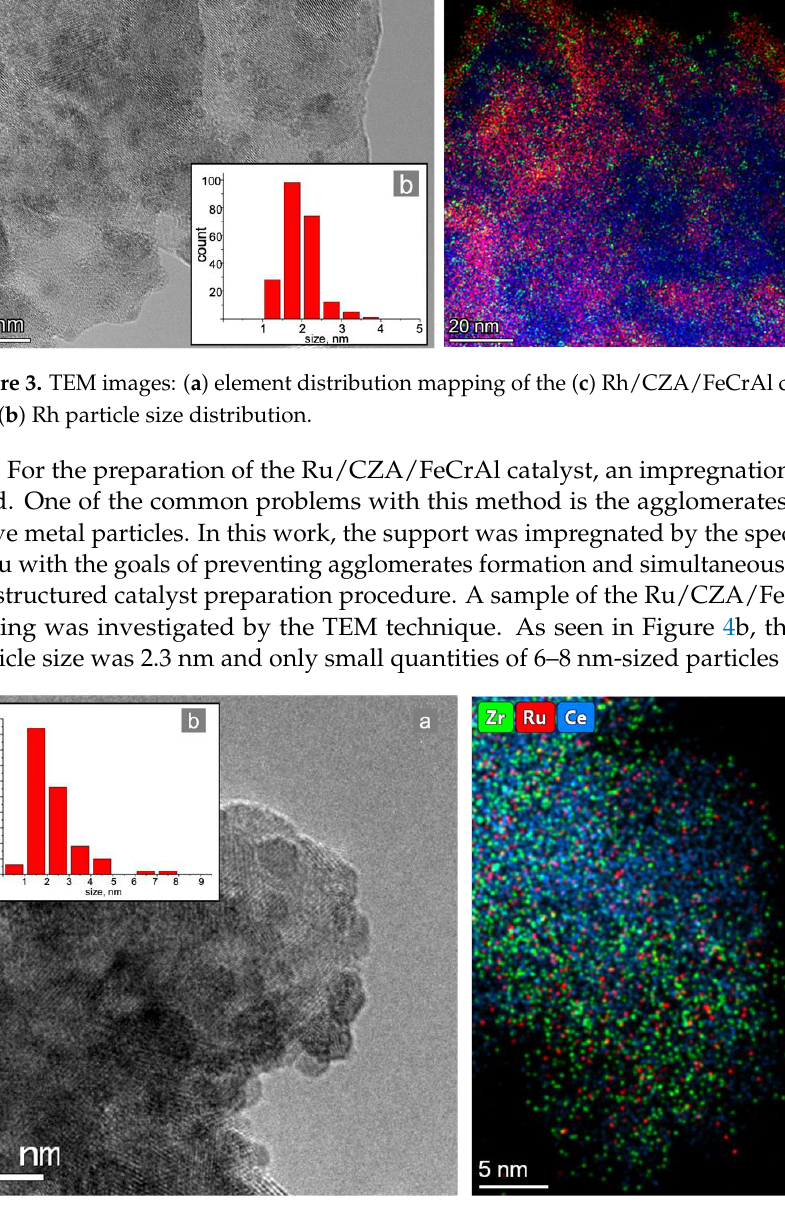
Figure 2. XRD patterns of the Al 2 O 3 /FeCrAl and FeCrAl: ( a ) 1 —reflexes of α -Al 2 O 3 , 2 — Fe and Cr (oxides), 3 — Fe, Cr (metals), and 4 —θ -Al 2 O 3 ; and ( b ) a sample of the supporting coating.